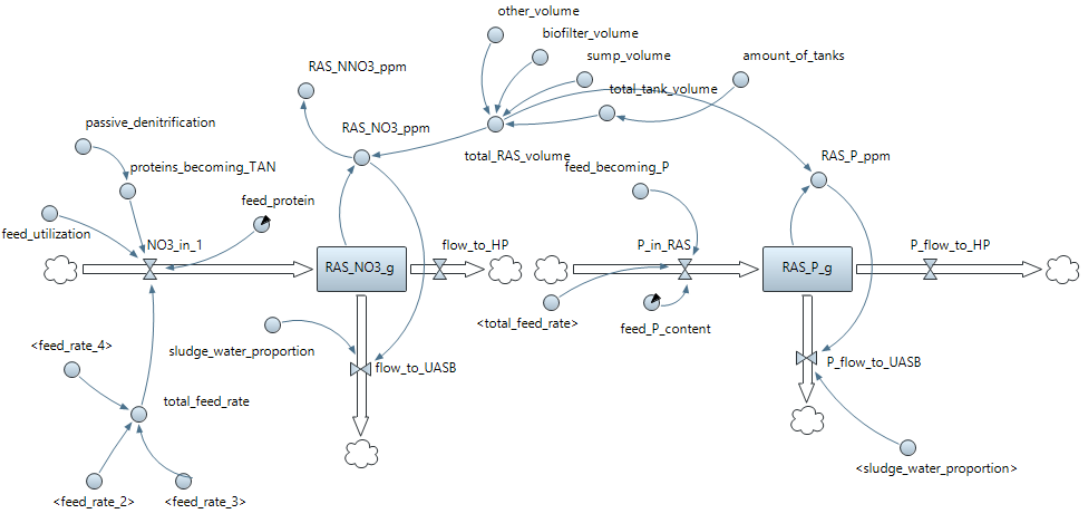
Figure A2. Software diagram of the nitrogen and phosphorus balance in the whole RAS system. The inflow is linked to Figure 13, whereas the outflow is linked to Figure A3 (ANRC) and A4 (hydroponics).